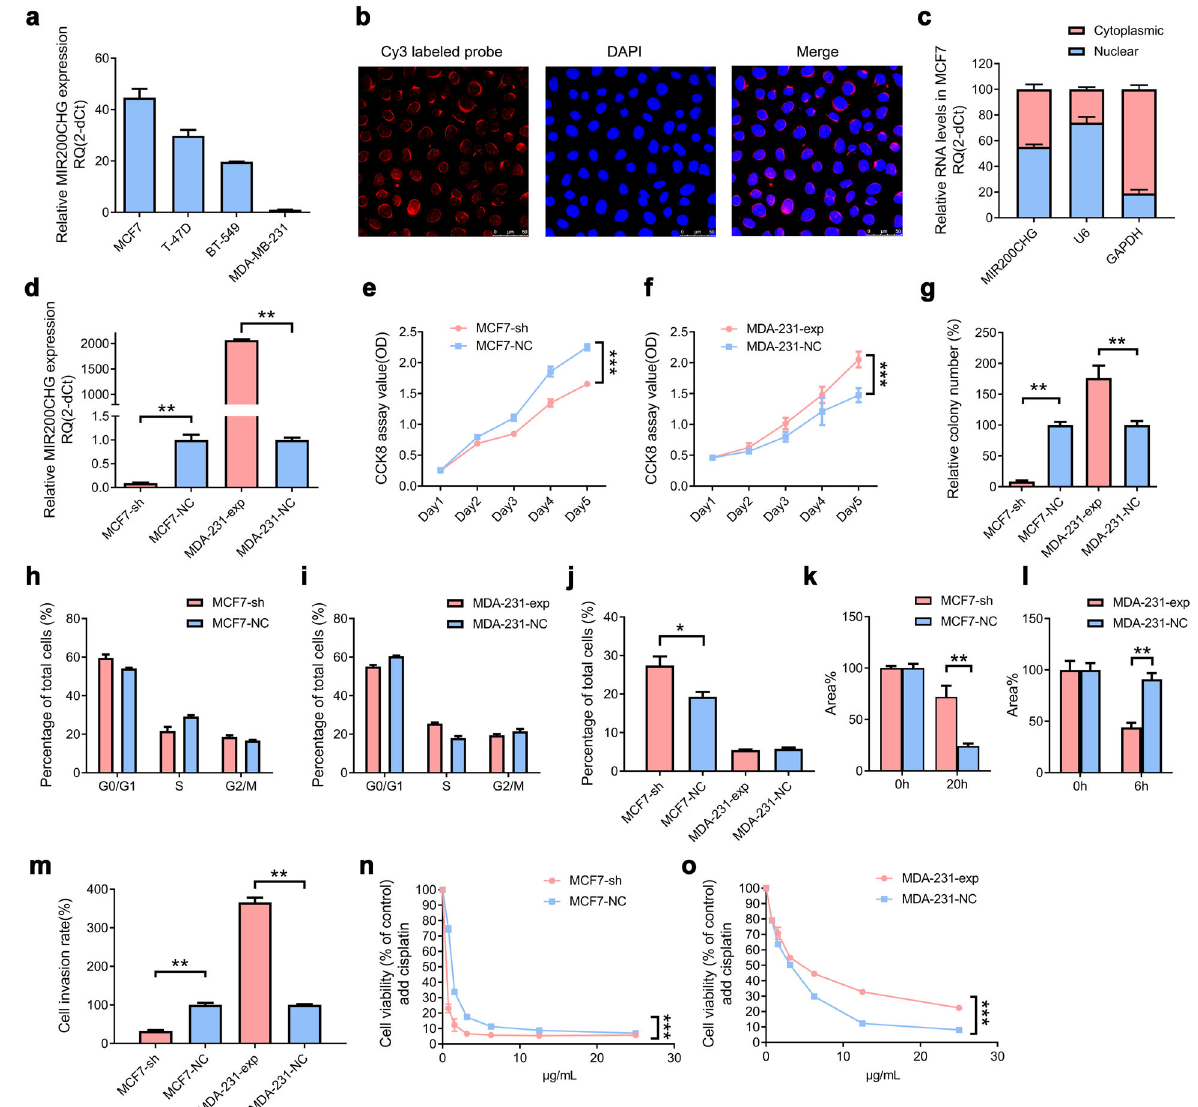
Fig. 2 MIR200CHG promotes breast cancer cell proliferation, invasion, and drug resistance in vitro. a qRT-PCR analysis of the expression levels of MIR200CHG in breast cancer cell lines (MCF7, T-47D, BT-549, MDA-MB-231). Experiments were performed at least three times in triplicate, and data are represented as mean ± SEM. MDA-MB-231 cells were used as a reference to calculate the relative expression of MIR200CHG. b Representative confocal microscope images of MIR200CHG distribution in MCF7 cells with immuno fl uorescence staining. (×630, oil lens). c qRT-PCR analysis of the distribution of MIR200CHG in the nucleus and cytoplasm of MCF7 cells. U6 was used as an internal reference for the quality of nuclear RNA extracted, and GAPDH was used as an internal reference for the quality of cytoplasmic RNA extraction. Data were con fi rmed in three independent experiments and are represented as mean ± SEM in triplicates. d Effects of knocking down or overexpressing MIR200CHG in MCF7 or MDA-MB-231 cells using the lentiviral system were detected by qRT-PCR. e , f CCK-8 assays showing the effects of MIR200CHG on breast cancer cell proliferation. g Effects of MIR200CHG on colony formation in breast cancer cells. h , i FACS analysis of the effect of MIR200CHG knockdown or overexpression on the cell cycle. j FACS analysis of the effect of MIR200CHG knockdown or overexpression on the cell apoptosis. The right quadrant shows the percentage of apoptotic cells. MCF7-sh group is about 27.40%, MCF7-NC group is about 19.31%; MDA-231-exp group is about 5.46%, MDA-231-NC is about 5.82%. k , l Wound healing experiment demonstrating the effects of MIR200CHG on the migration ability of breast cancer cells. m Transwell assay showing the effects of MIR200CHG on the invasion ability of breast cancer cells. MCF7 cells were incubated for 24 h, and MDA-MB-231 cells were incubated for 10 h. n , o CCK-8 assays demonstrating the effects of MIR200CHG expression on the sensitivity of breast cancer cells to cisplatin. Experiments in ( d – o ) were performed at least three times in triplicate, and data are represented as mean ± SEM. Two-way ANOVA were used to analyze the data in ( e , f , n , o ) and two-tailed T test was used to analyze the data in ( d , g – m ). * P < 0.05, ** P < 0.01, *** P <